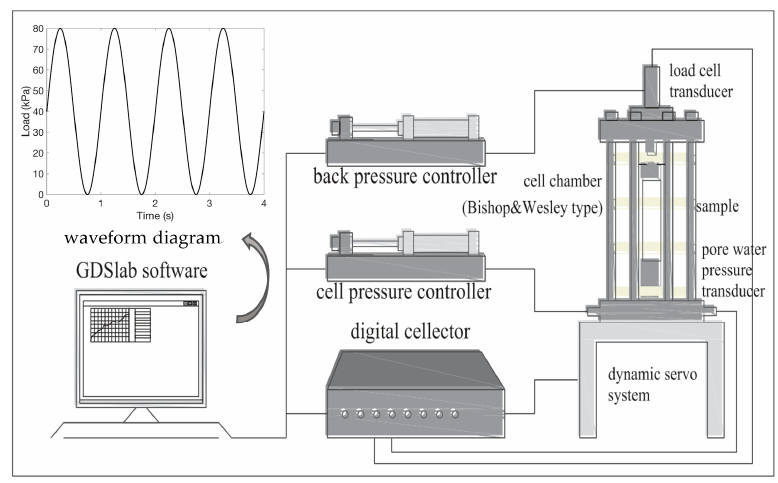
Figure 4. Components of the dynamic triaxial test machine.